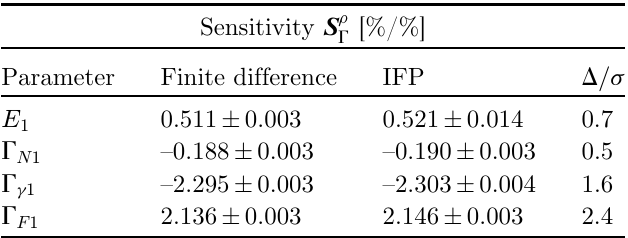
Table 4. Cross sections and angular distribution con- tributions to PMF001 parameters reactivity sensitivities.